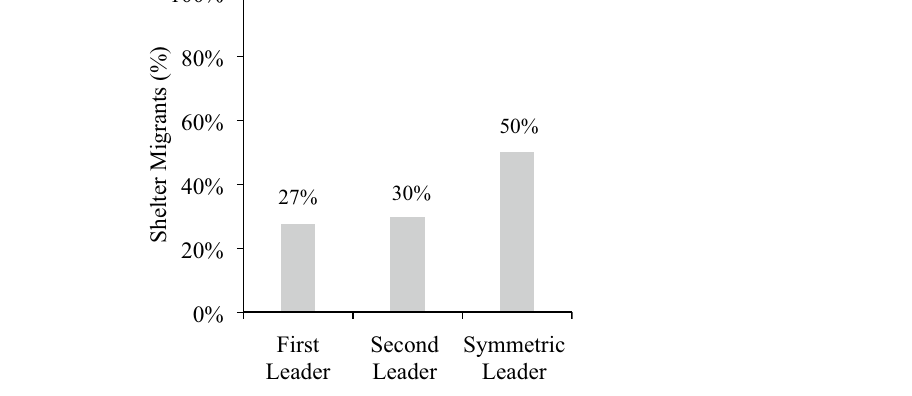
Figure 4. Participants’ decisions to shelter by